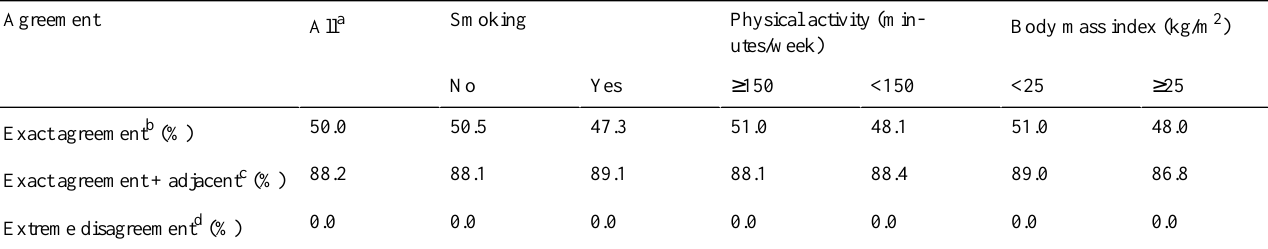
Table 11. Cross-classification analysis derived from the electronic 12-hour dietary recall app versus the 4 dietary records for categories of food group consumption and strata: smoking: no and yes; physical activity (minutes/week): ≥ 150 and <150; and body mass index (kg/m 2 ): <25 and ≥ 25. Comparison of the electronic 12-hour dietary recall app versus dietary records.